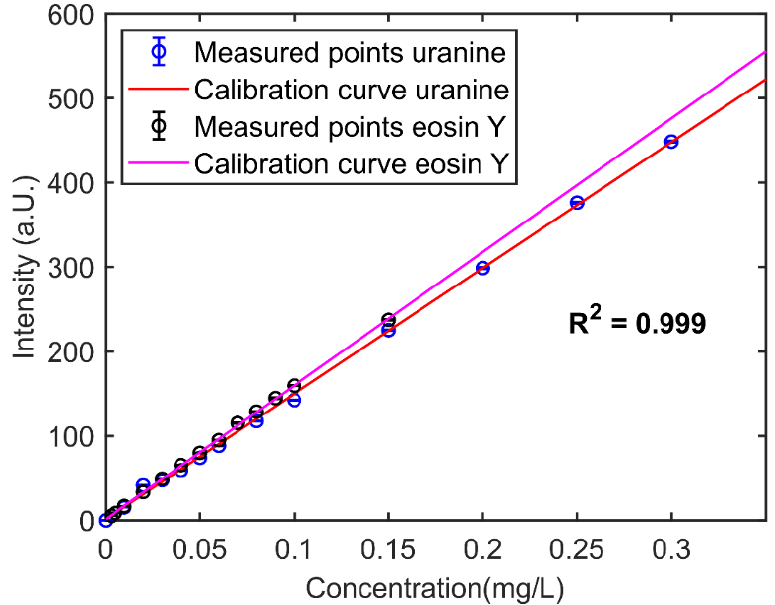
Figure A1. Calibration curve for uranine AP and eosin Y.